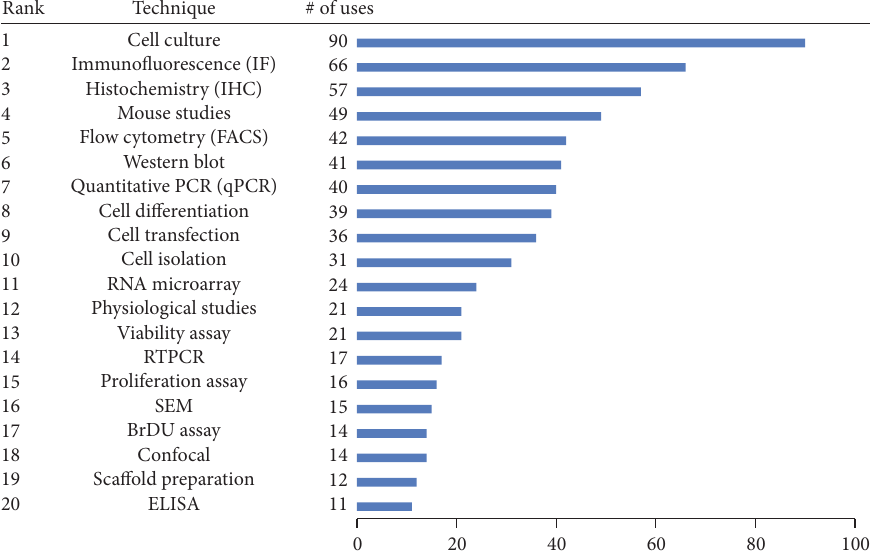
Figure 2: Top 20 techniques utilized in the reviewed regenerative medicine publications. The top 20 most common techniques identified through this literature review of regenerative medicine articles are listed in descending order. The most commonly used technique was cell culture which was used in 90 of the studies we investigated in this review. Of the data points collected the top 20 techniques comprised greater than 70% of the techniques used.